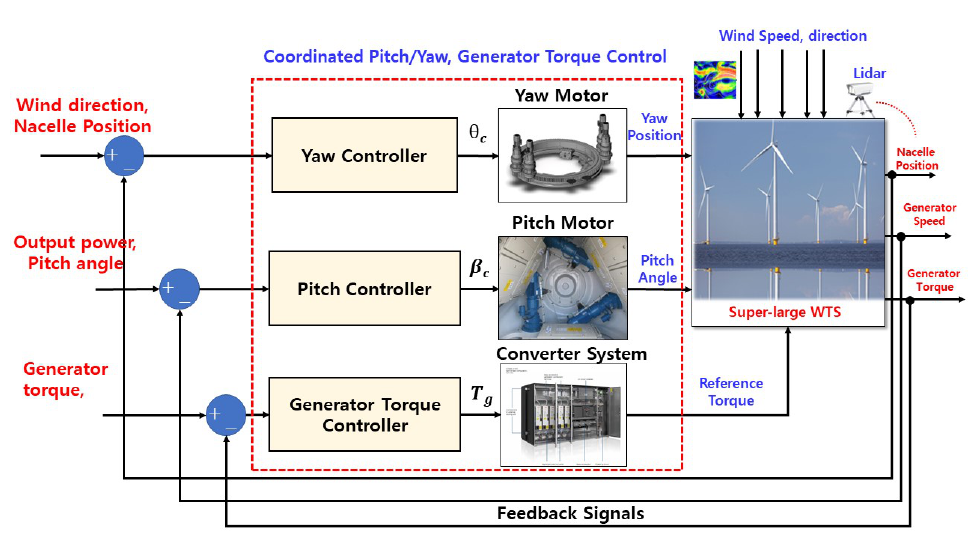
Figure 16. Block diagram of the coordinated pitch/yaw and generator torque control method for super-large